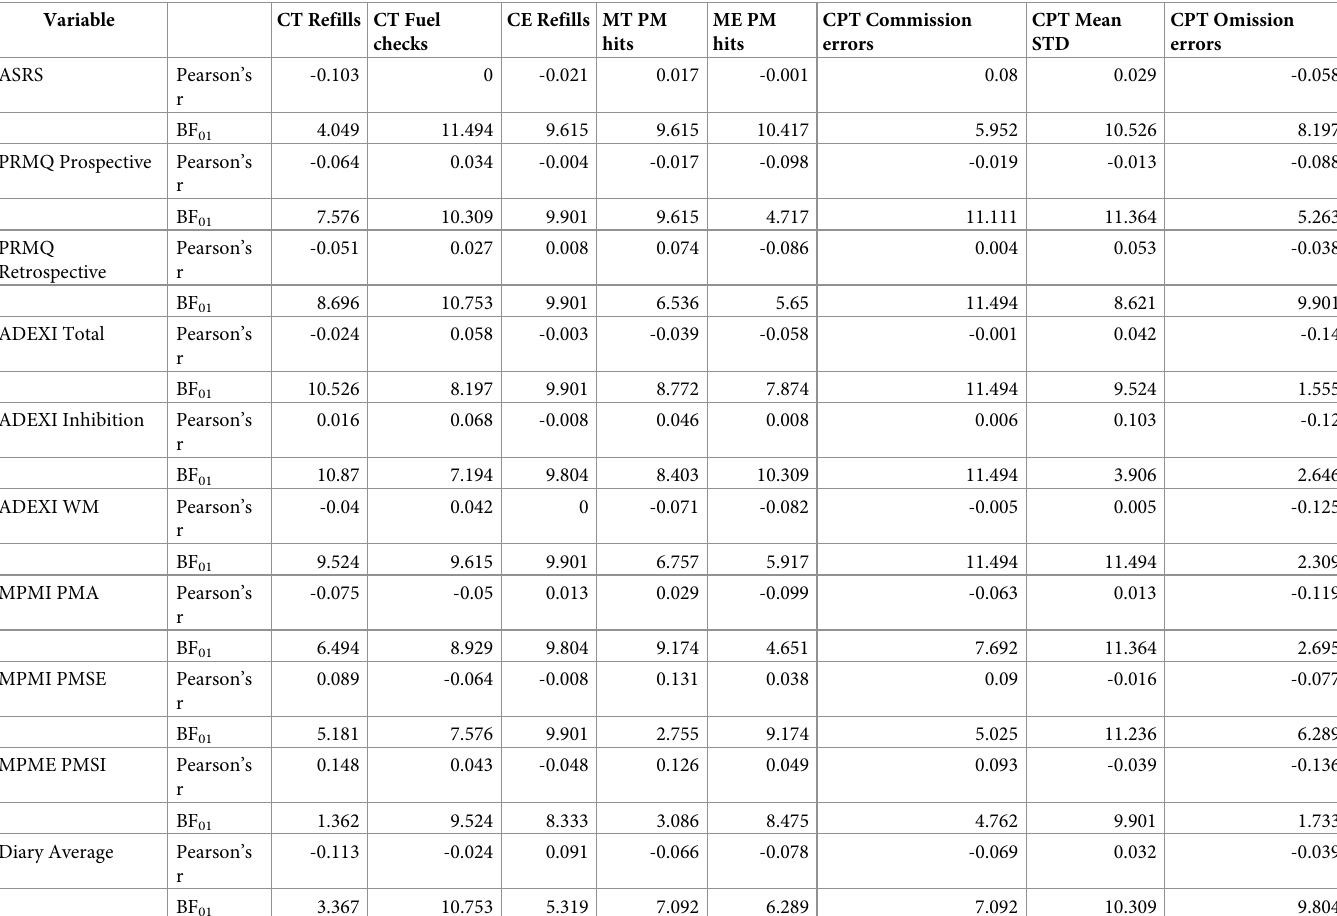
Table 8. Associations between the conventional PM tasks and CPT with the questionnaires. Inverted Bayes Factors (BF 01 ) are reported, indicating evidence for the null hypothesis. Variable CT Refills CT Fuel